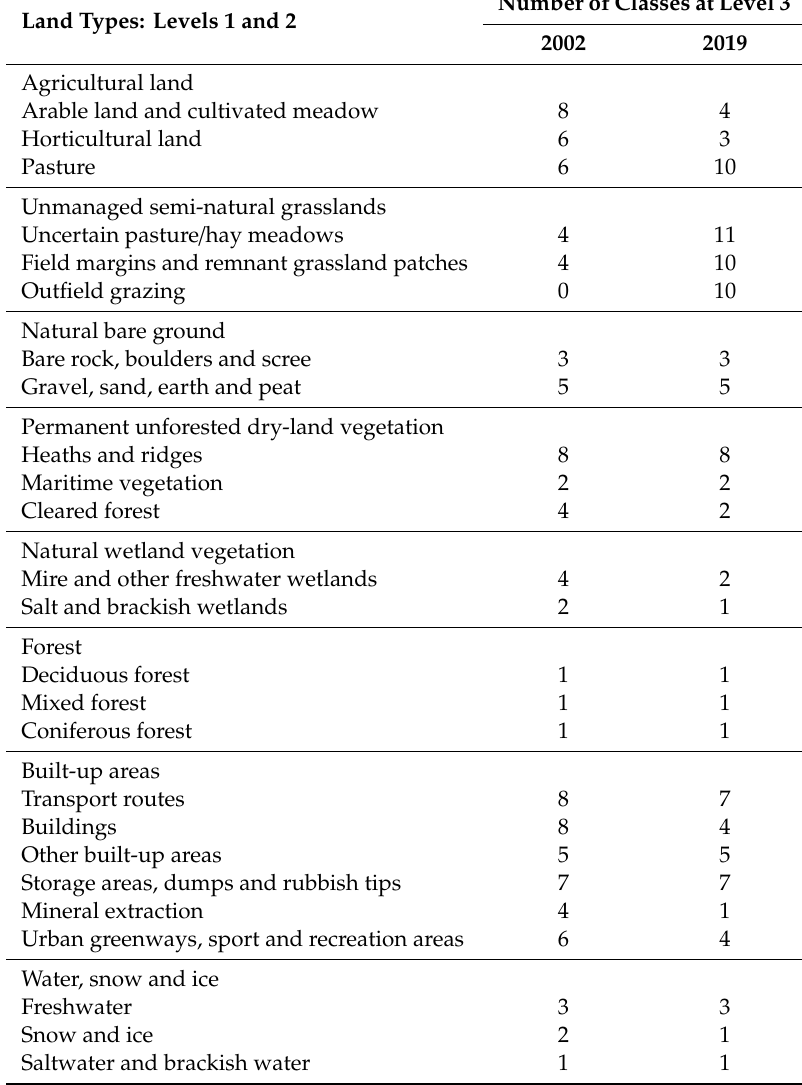
Table 1. Land types at levels 1 and 2 in the hierarchical classification system, and number of classes at level 3, during the first round of monitoring (version 2002) and third round of monitoring (version 2019). Land Types: Levels 1 and